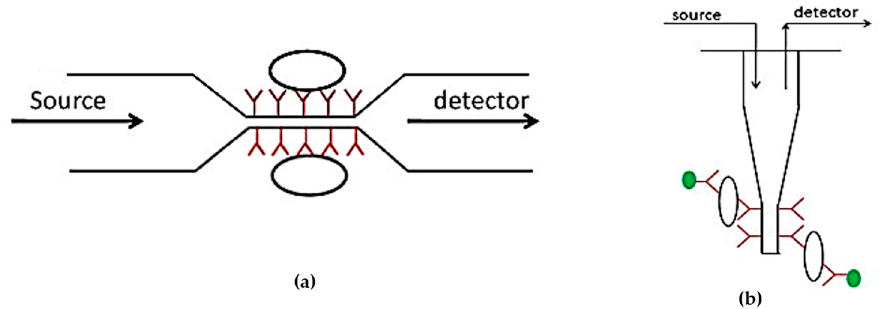
Figure 7. ( a ) Schematic diagram of a tapered optical biosensor; ( b ) Schematic diagram of a tapered tip optical biosensor [89].